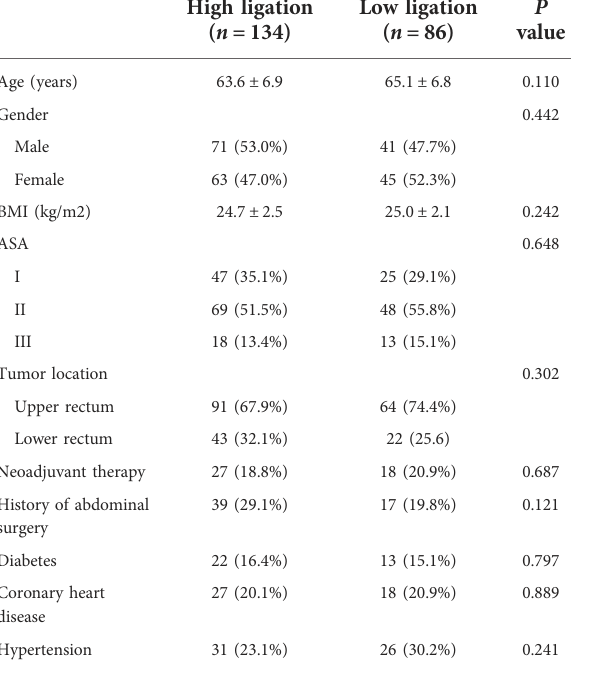
TABLE 1 Patients ’ baseline and clinical characteristics.